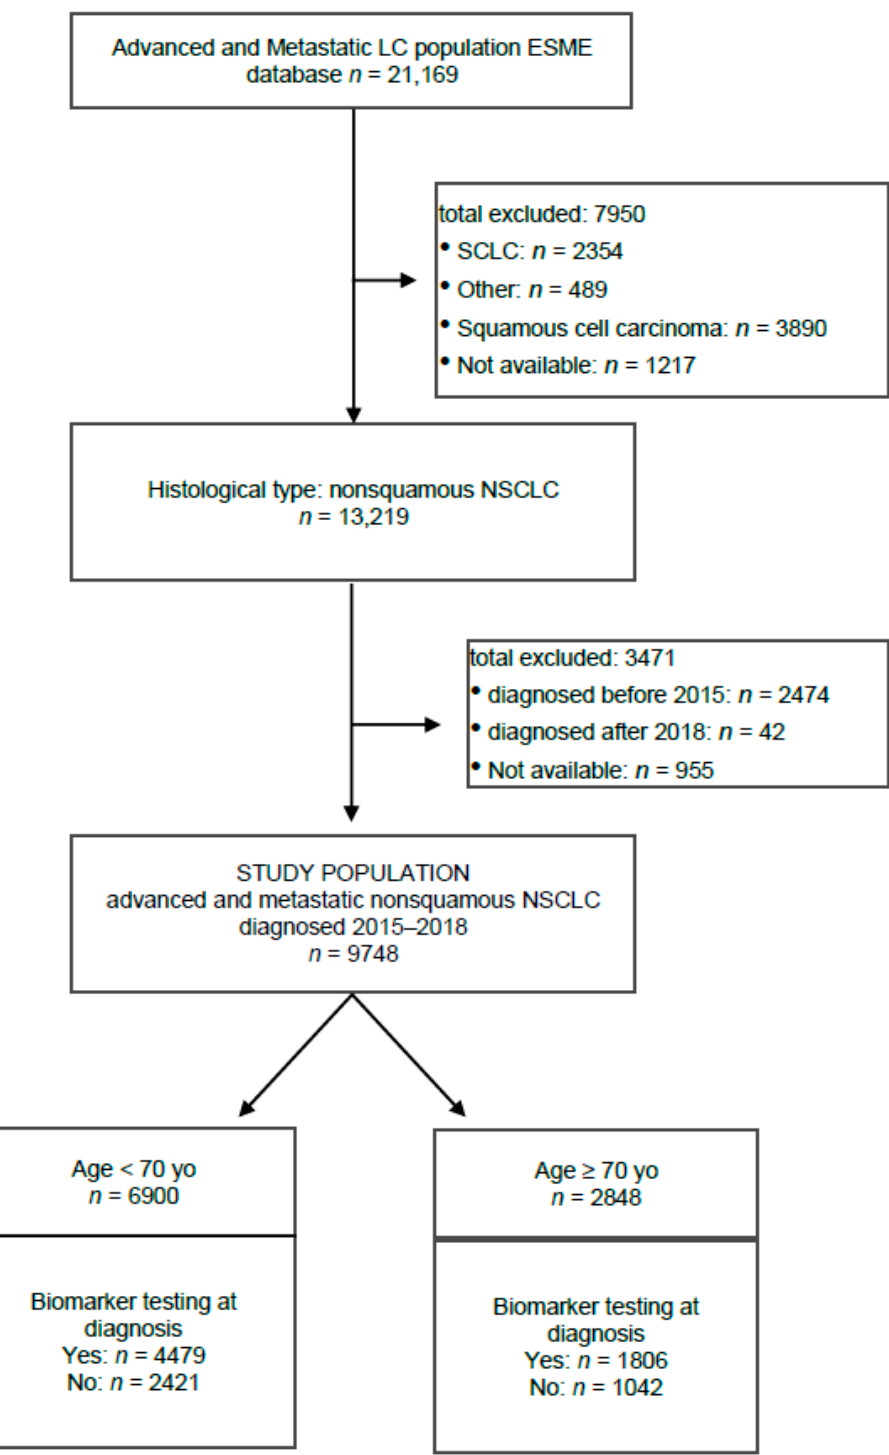
Figure 1. Study flow chart. LC: Lung cancer; SCLC: Small-Cell Lung Cancer; NSCLC: Non-Small-Cell Lung Cancer; yo: Years old.